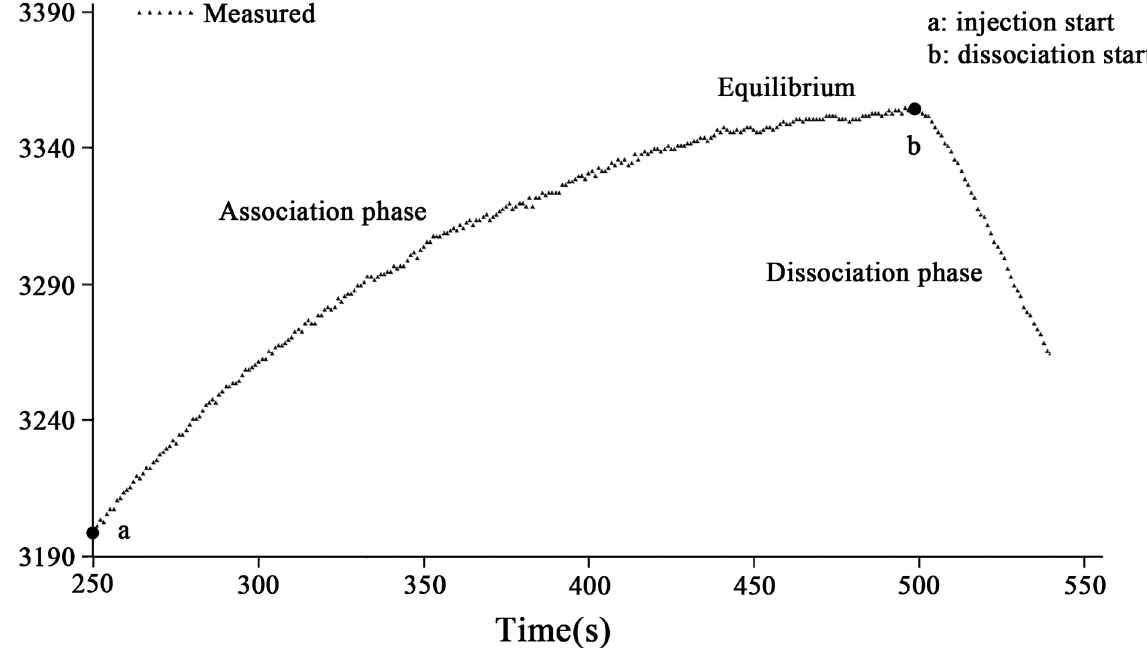
Fig 1. Sensorgram showing the association and dissociation processes of biomolecular interaction between HBsAg and HbsAb. The data marked with a triangle is obtained in the average of more than three sets of measurement results in RU. This sensorgram is showing that the HBsAg was binding on the specific HBsAb (association phase) starting from the injection point a and reaches an equilibrium after approximately 251s. From the dissociation starting point b, the dissociation phase was formed sequentially. The microfludic cell of this SPR bioanalyzer was kept at a constant temperature of 37°C.